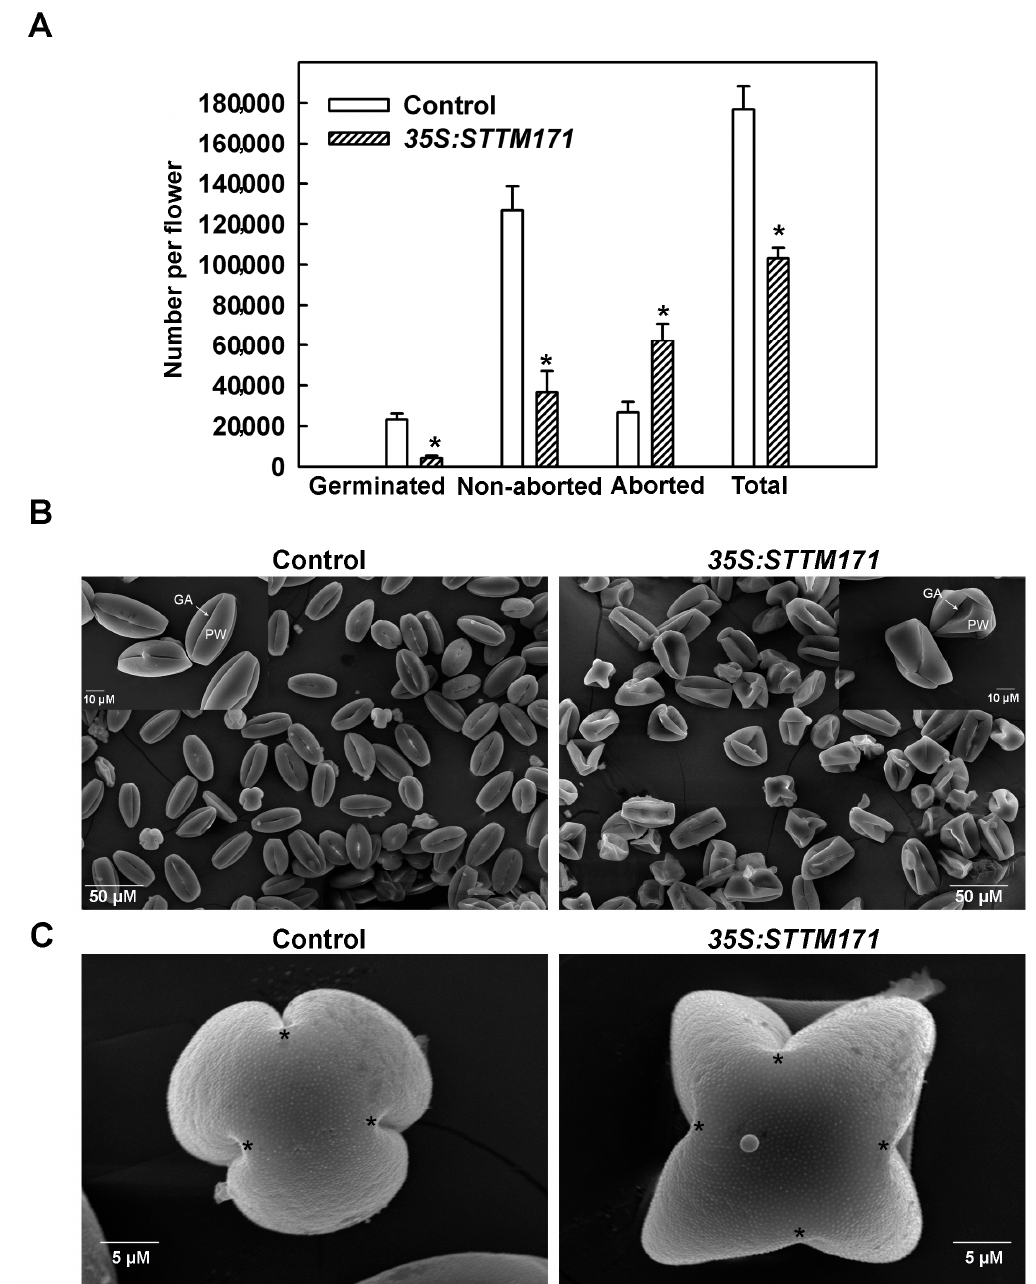
Figure 4. Effect of miR171 family downregulation on pollen quality and quantity. ( A ) Quantitation of total, aborted, non-aborted, and germinated mature pollen grains per anthesis flower of indicated genotype (n = 30). Asterisks indicate significant difference as determined by Student’s t -test ( p ≤ 0.01). ( B ) Scanning electron micrographs of dehydrated pollen grains from indicated genotypes. Note the high number of collapsed pollen grains in the 35S:STTM171 sample. Inset shows magnified views of few representative pollen grains from each genotype. PW: pollen wall; GA: germinal aperture. ( C ) Scanning electron micrographs of polar view of representative mature pollen grains from indicated genotypes. The locations of the germinal aperture are indicated by asterisks.